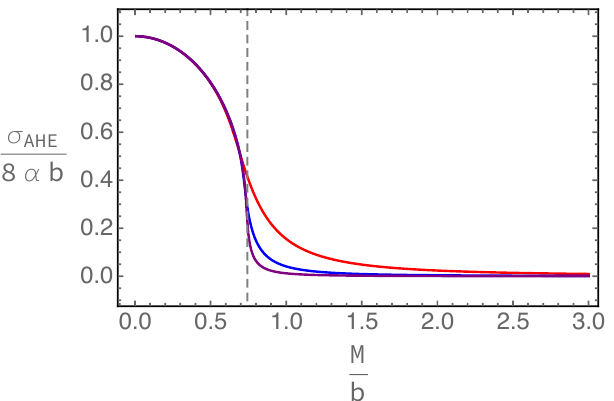
Figure 1 . Plot of anomalous Hall conductivity as a function of M/b at the temperatures T/b = 0 . 05 (red), 0 . 02 (blue), 0 . 01 (purple). The gray dashed line is the critical value of M/b of the quantum phase transition at zero temperature.